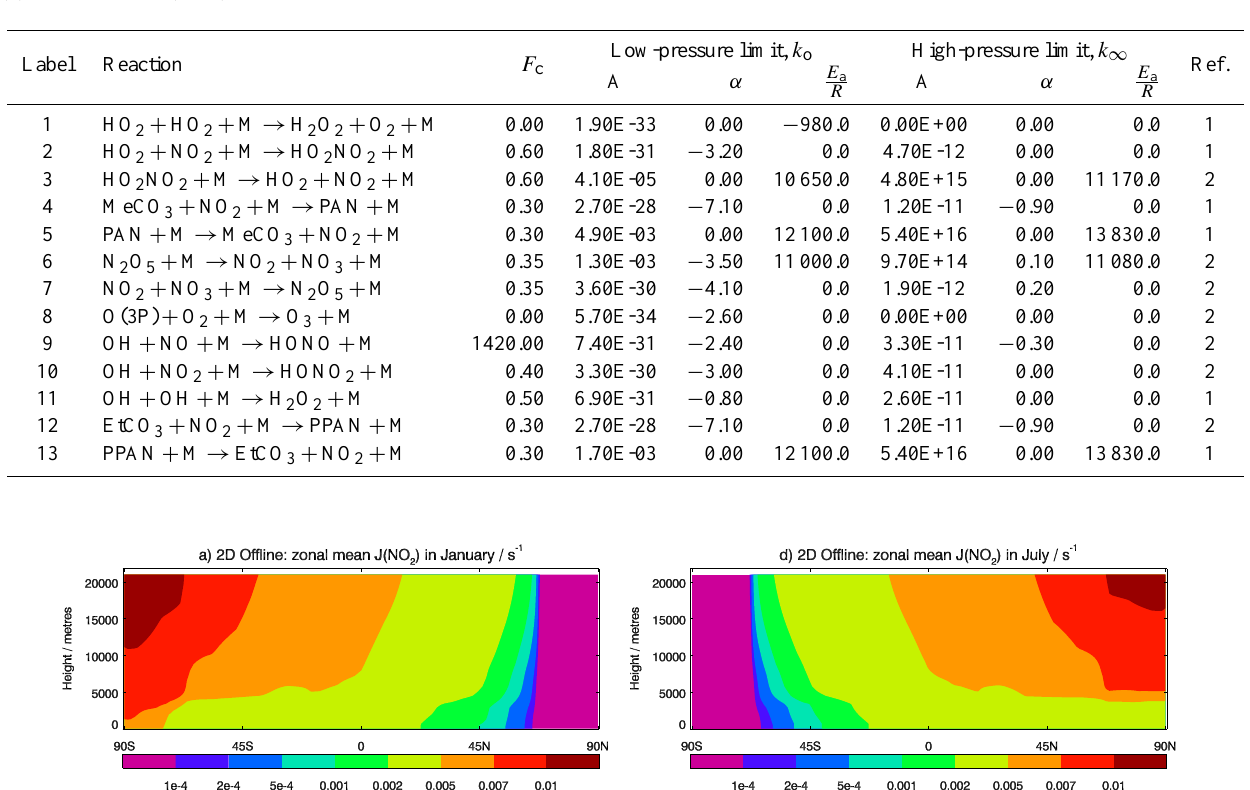
Table 6. Uni- and termolecular reactions in the UKCA standard tropospheric (StdTrop) scheme, where Me = CH 3 , Et = C 2 H 5 , PAN = peroxy acetyl nitrate, and PPAN = peroxy propionyl nitrate. Rate coefficients for termolecular reactions are calculated using a modified Lindemann– (cid:18) (cid:19) 1 + log k o [ M ] F Hinshelwood mechanism, i.e. k = c , where k o and k ∞ are the low- and high-pressure limits calculated in the 1 + k o [ M ] k ∞ same manner as bimolecular rate coefficients, and [ M ] is the number density in molecules cm − 3 . References: (1) Atkinson et al. (2000), (2) Atkinson et al. (2003).